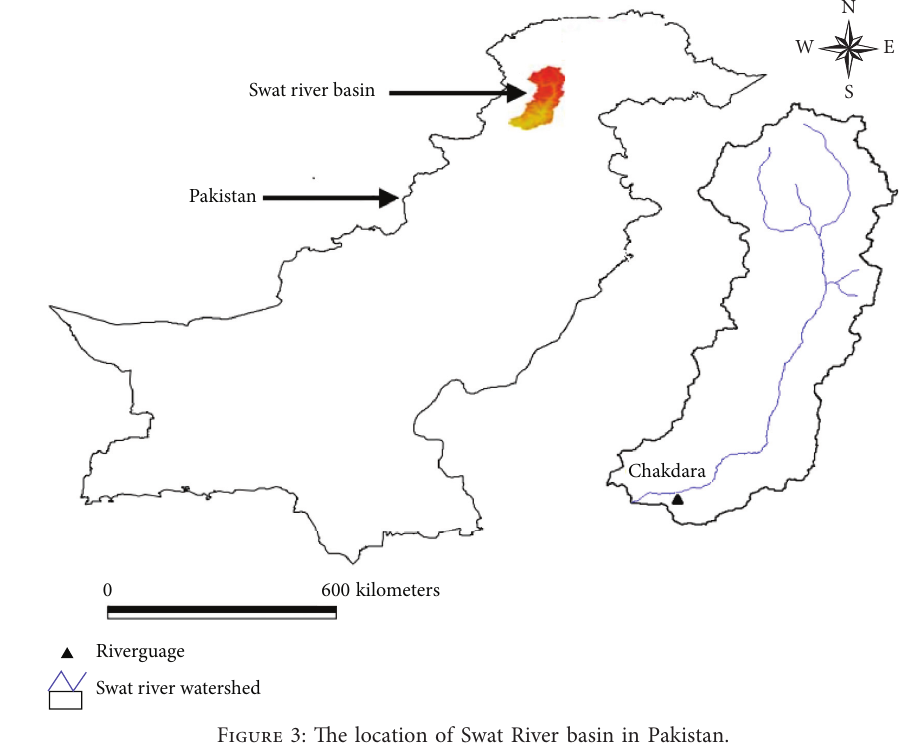
Figure 3: The location of Swat River basin in Pakistan.